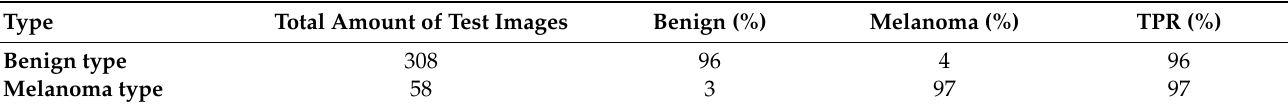
Table 6. ISIC 2017 dataset confusion matrix.